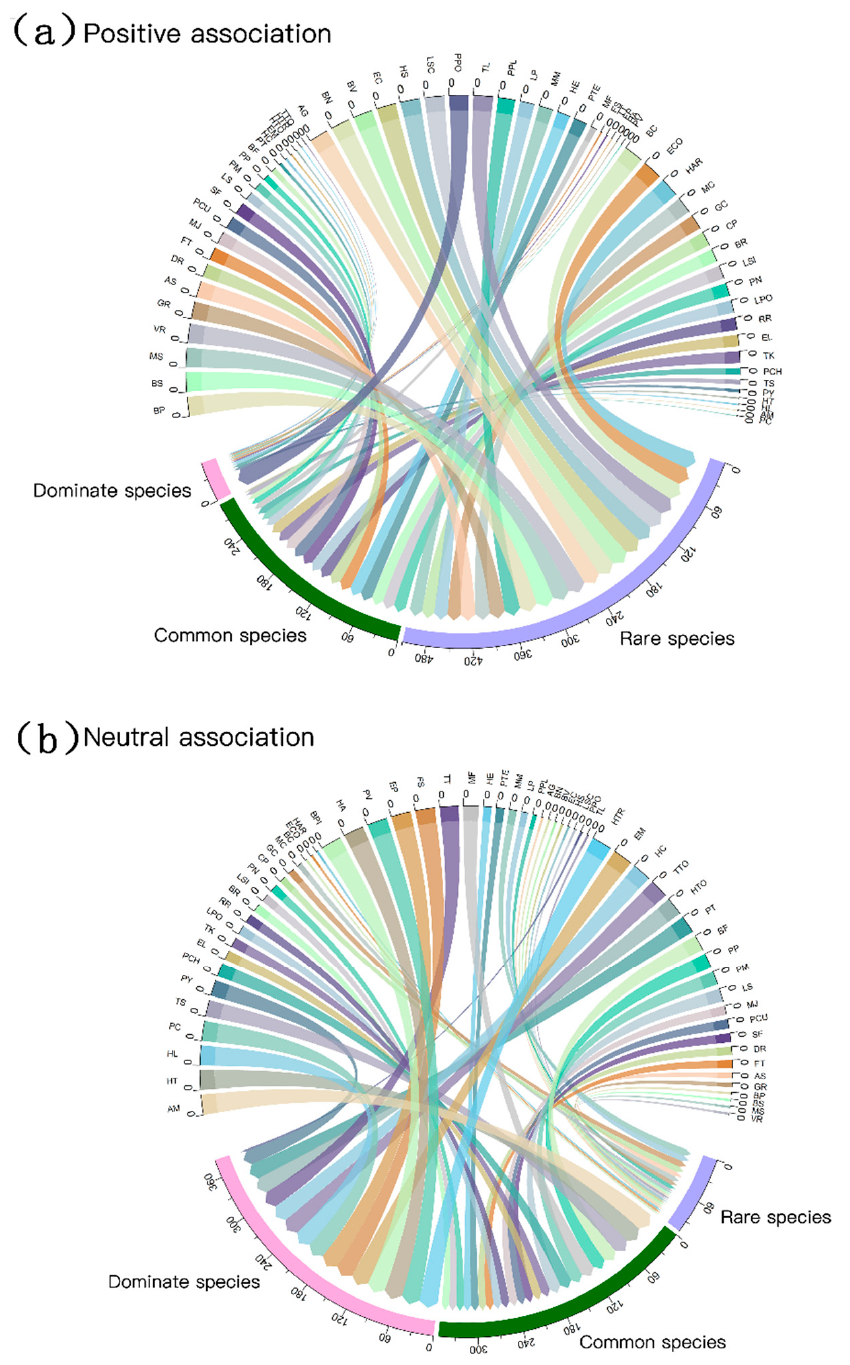
Figure 5. Associations between different groups of bryophytes (rare, common, or dominant species of epiphytic bryophyte) and woody plants based on the results of torus-translation test. The entire network includes all the 28 woody plant species and 61 bryophyte species. There are too few bryo- phyte species negatively associated with woody plants, so they are not shown here. The abbrevia- tions of woody plants are shown in Table S4. The different groups of bryophytes are shown in Table S6. ( a ) shows the positive correlation, while ( b ) shows the negative